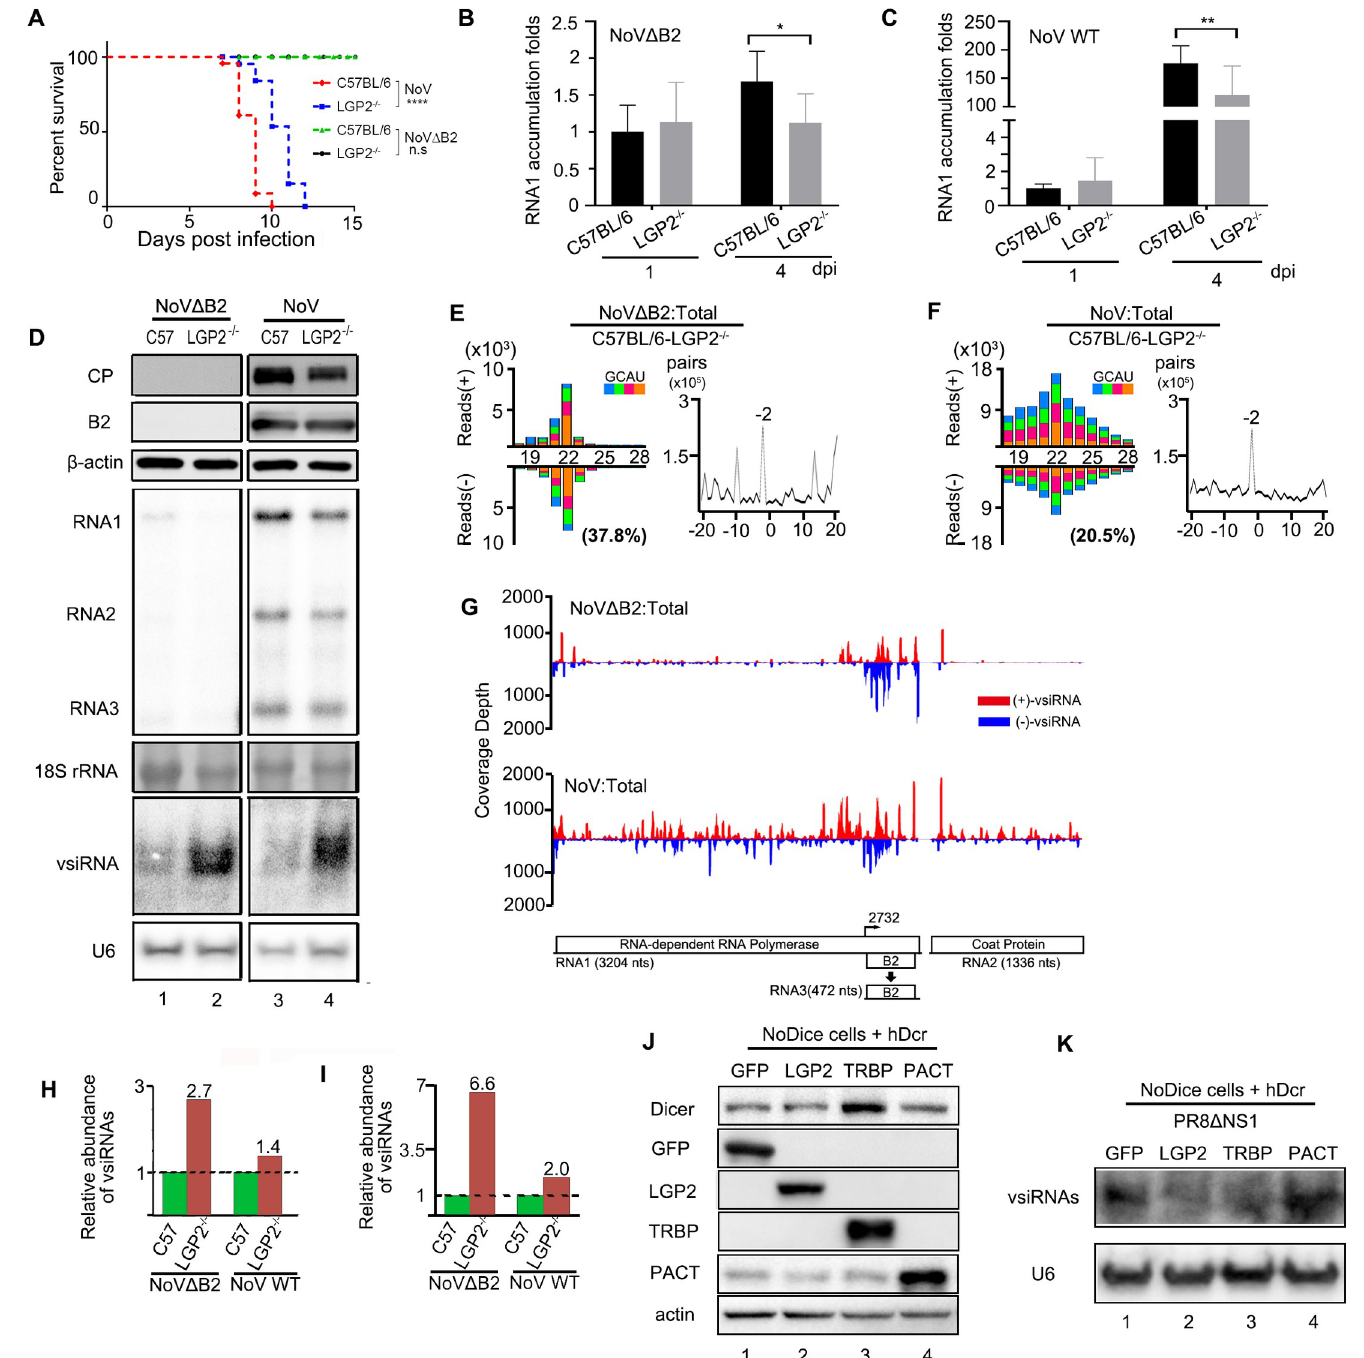
Fig 6. Enhanced production of vsiRNAs and reduced virulence of NoV in Dhx58 -/- suckling mice compared to parental C57BL / 6 mice. A. Survival curve of C57BL/6 and Dhx58 -/- suckling mice inoculated with WT NoV. Data analysis was performed using GraphPad Prism. n = 12~14. Log-rank (Mantel-Cox) test. ���� indicates p < 0.0001. B, C RNA1 accumulation level of NoV Δ B2 (B) or WT NoV (C) measured by RT-qPCR from hindlimb of C57BL/6 or Dhx58 -/- suckling mice at 1 or 4 dpi. The RNA1 level of NoV Δ B2 infected C57BL/6 suckling mice at 1 dpi was set as 1. Error bars indicate standard deviation of three replicates. � indicates p < 0.05, �� indicates p < 0.01 (Student’s t-test). D. Western blotting detection (upper 3 panels) of the viral coat protein (CP) and B2 protein in C57BL/6 or Dhx58 -/- suckling mice infected with NoV Δ B2 or NoV at 4 dpi. Detection of the endogenous β -actin was used as a loading control. Northern blotting detection (lower 4 panels) of viral genomic RNAs and vsiRNAs in C57BL/6 and Dhx58 -/- suckling mice inoculated with NoV Δ B2 or NoV at 4 dpi. Detection of 18S rRNAs and U6 were used as loading controls. E, F. Size distribution 18- to 28-nt virus-derived small RNAs (left) and duplex pattern of the 22-nt vsiRNAs (right) from NoV Δ B2 (E) or WT NoV (F) infected Dhx58 -/- suckling mice at 4 dpi. Reads shown as per million total mature miRNAs. The 5’ terminal nucleotide and 1U % of 21- to 23-nt vsiRNAs were indicated. G. The